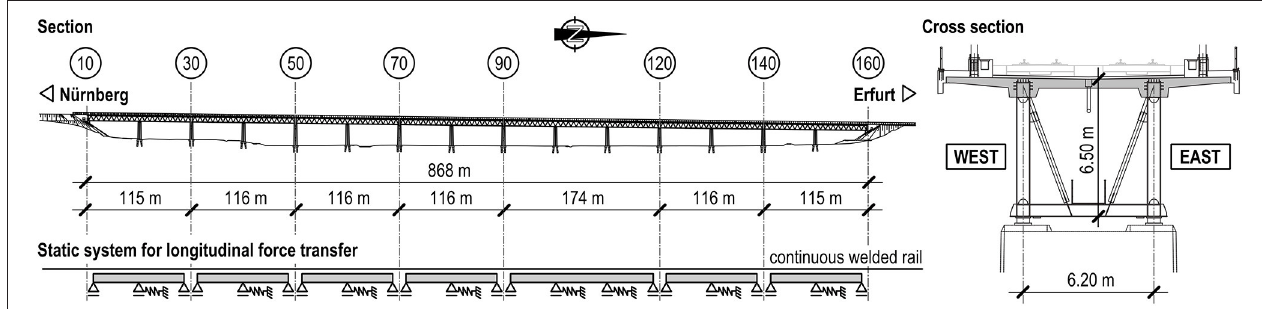
FIGURE 2 | Longitudinal section, cross section, and static system of the Itz valley railway viaduct.